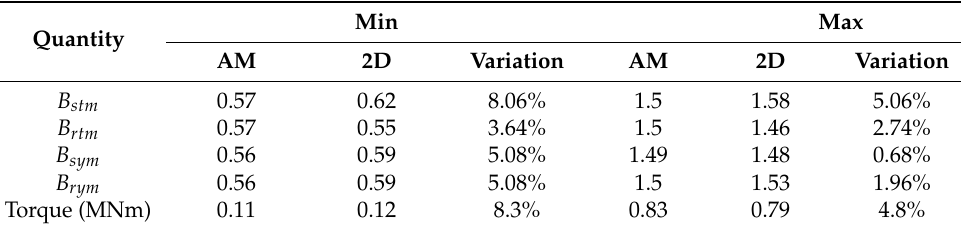
Table 4. Maximum torque and magnetic field at the minimal and the nominal operating points.